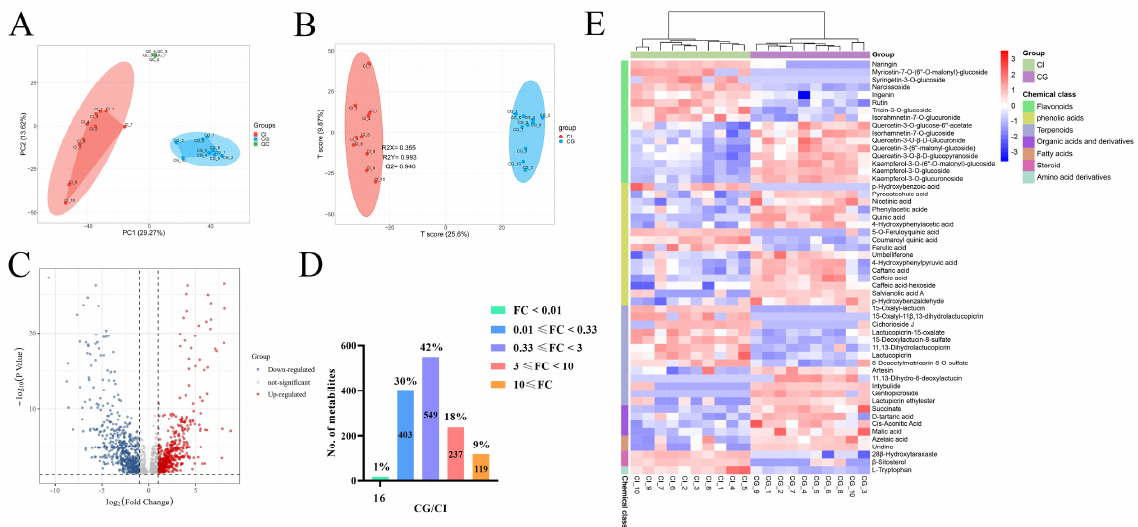
Figure 2. The multivariate analysis of metabolites in CG and CI. ( A ) Principle component analysis (PCA) plot; ( B ) score scatter plot of the OPLS-DA model; ( C ) volcano plot of differential metabolites; ( D ) differential comparison of metabolite intensity; ( E ) heat map of CG and CI. Significantly up- and downregulated metabolites are indicated in red and green, respectively. Those without significant difference between the two groups are indicated in grey. A greater absolute value on the horizontal axis indicates a greater foldchange between CG and CI. A greater value on the vertical axis indicates greater significance.